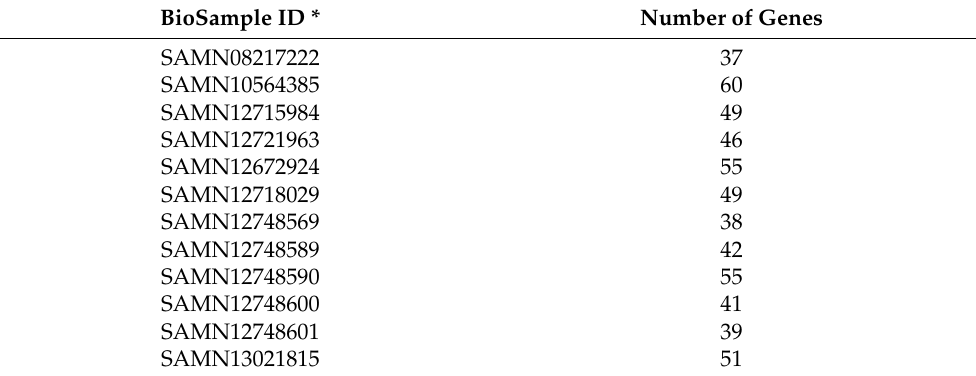
Table 4. Number of genes in the non-reference contigs mapped to the heat-tolerant QTLs in each reference